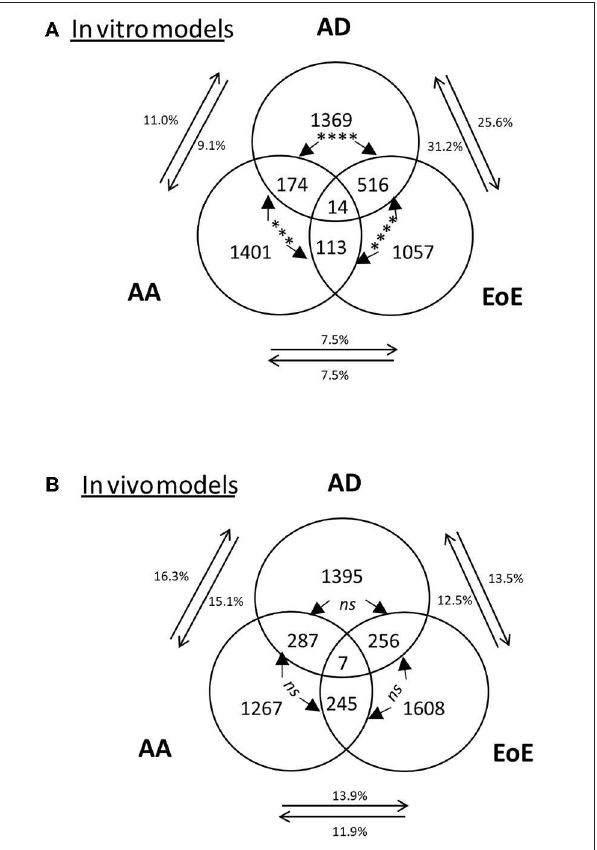
FIGURE 3 | Representation of the dysregulated genes and overlaps among in vitro and in vivo models. Venn diagram of dysregulated transcripts in (A) in vitro models and (B) mouse models. The 3 amounts of dysregulated genes in EoE, AD, and AA in (A) in vitro models or (B) in vivo models and their respective overlaps are shown, with the number of transcripts indicated. The percentages of genes in each disease gene group that overlap with those of another disease are shown. Chi-square tests were used to compare transcript overlaps for each disease model with the two other disease models. P -values are shown for each comparison of overlap (between arrows); *** p < 0.0005;**** p < 0.0001 “ ns” is not